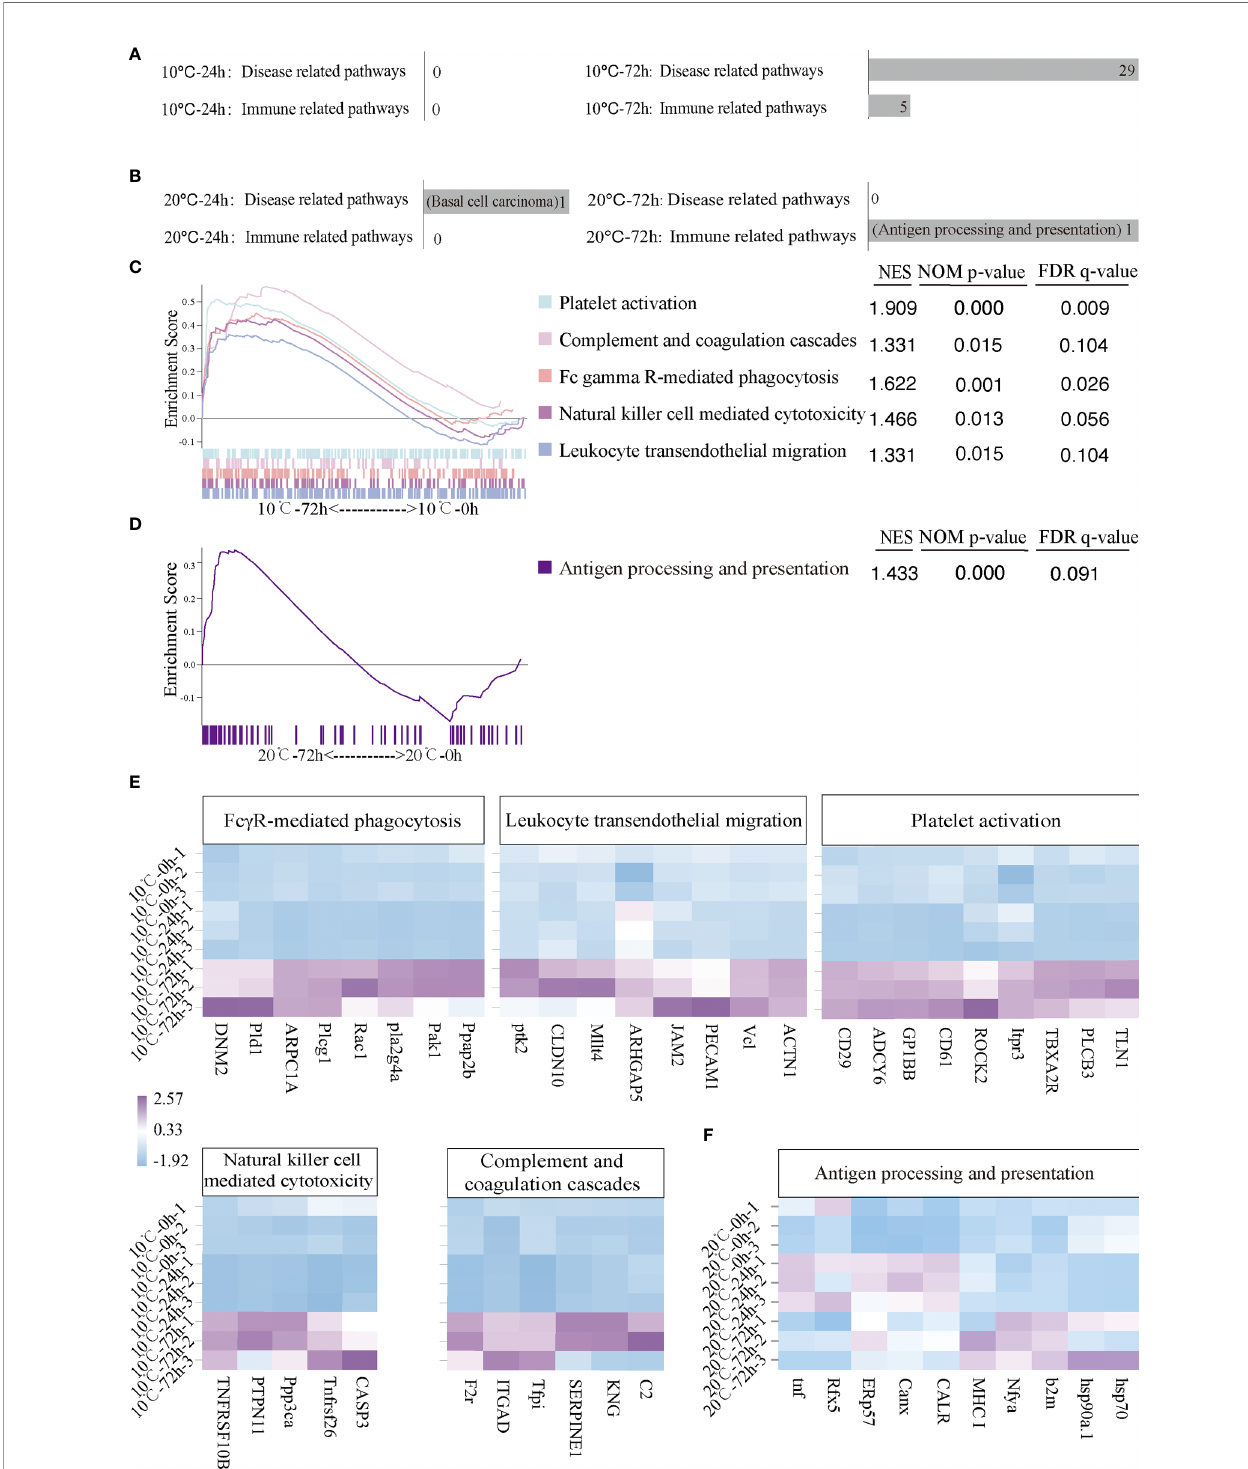
FIGURE 4 | Activated immune related and disease related pathways and related genes of infected fl ounder maintained at 10°C and 20°C. (A, B) The number of activated disease-related and immune-related pathways at 10°C and 20°C. (C, D) The activated immune-related pathways in 10°C-72 hpi group and 20°C-72 hpi group. NES values of the pathways with p < 0.05 are presented. (E, F) The heatmap of immune genes in each activated immune-related pathway at 10°C and